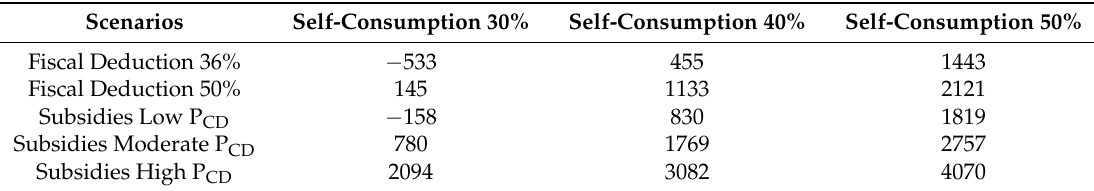
Table 2. NPV in baseline scenario. Data expressed in € .